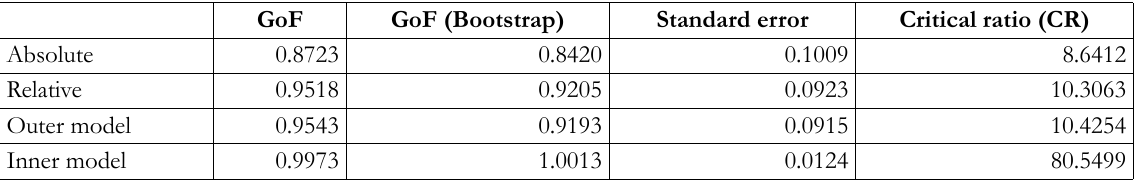
Table 8. The Goodness of fit index of